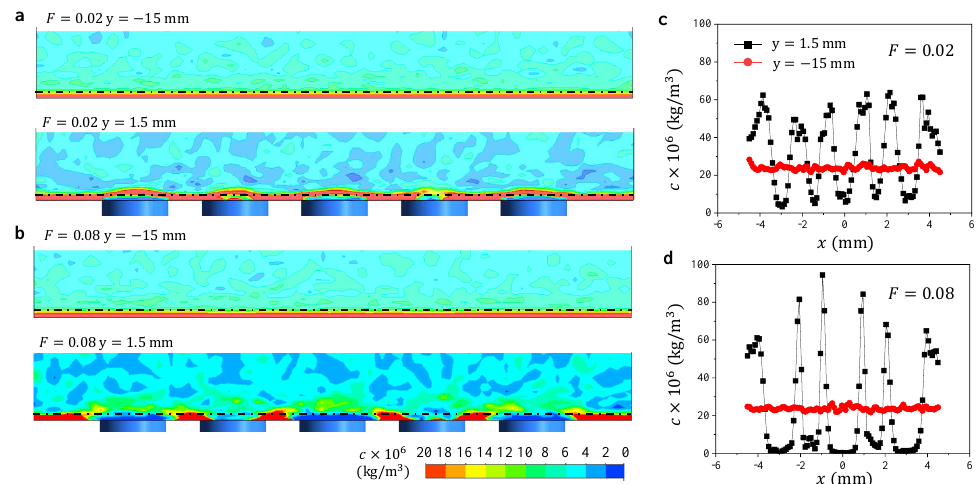
Figure 10. The contours of the particle concentration c in the x − z cross section before the hole ( y = − 15mm, upper panel) and after the hole ( y = 1.5mm, lower panel) for ( a ) F = 0.02 and ( b ) F = 0.08. The variation of particle concentration c with x along the dash-dot lines ( z = 0.5mm) in ( a ) and ( b ) for ( c ) F = 0.02 and ( d ) F =